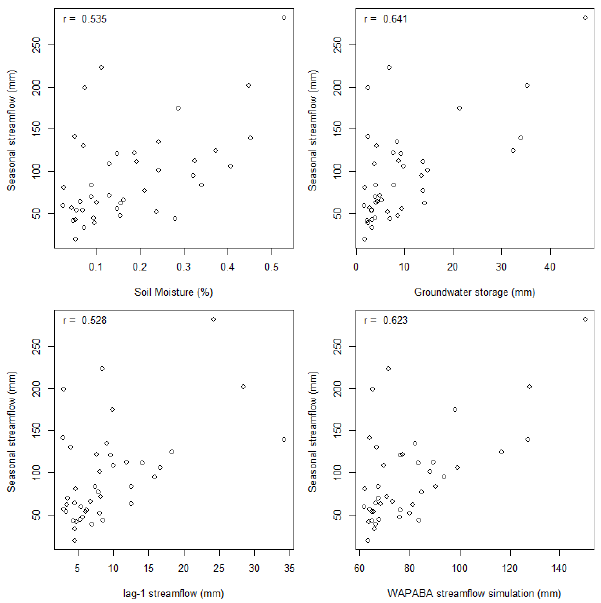
Fig. 13. The relationship between May-June-July streamflow to- tals and the WAPABA state variables at the end of April. April streamflow and WAPABA simulations for May-June-July for Kiewa River inflows into the Murray River (Pearson correlation coeffi- cients shown in top left corner of each plot).